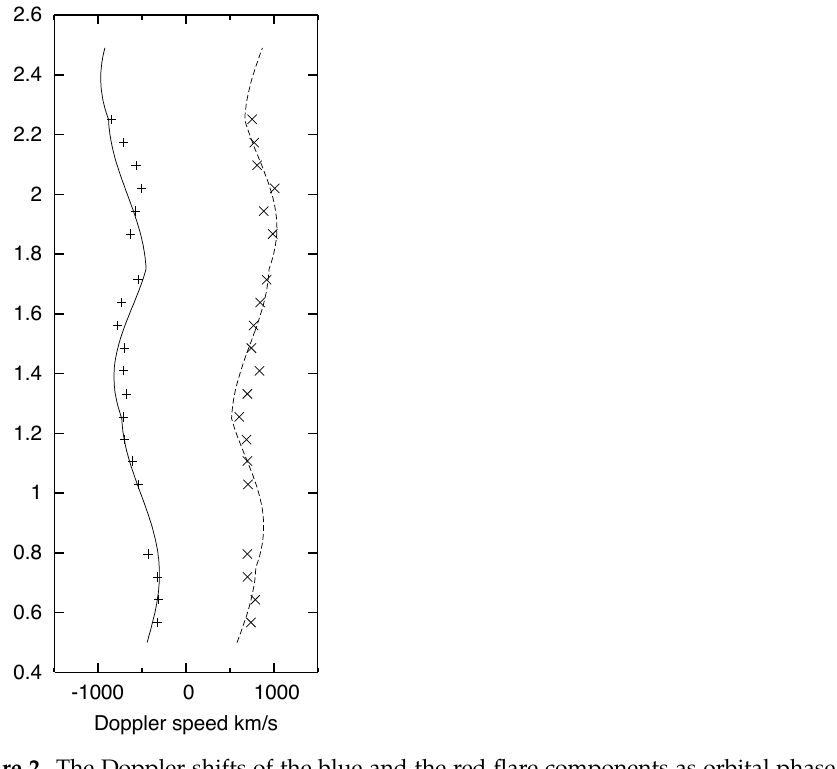
Fig.2. The radial velocities of the extreme red and blue components of Figure 2. The Doppler shifts of the blue and the red flare components as orbital phase advances H α . Although the data are barely adequate for the purpose, they show (from [9]). This pattern reveals a distinct memory of orbital phase. The superimposed curves assume an oscillation of amplitude consistent with 175 km s − 1 , period 13 days, a source in an accretion disk; the memory could also be caused by L 2 expulsion of plasma (see and a slowly increasing separation of the two components. The orbital phase is given in units of the period, with phase 1 corresponding to JD + 294. The superimposed curves are for the simple model described in the text.